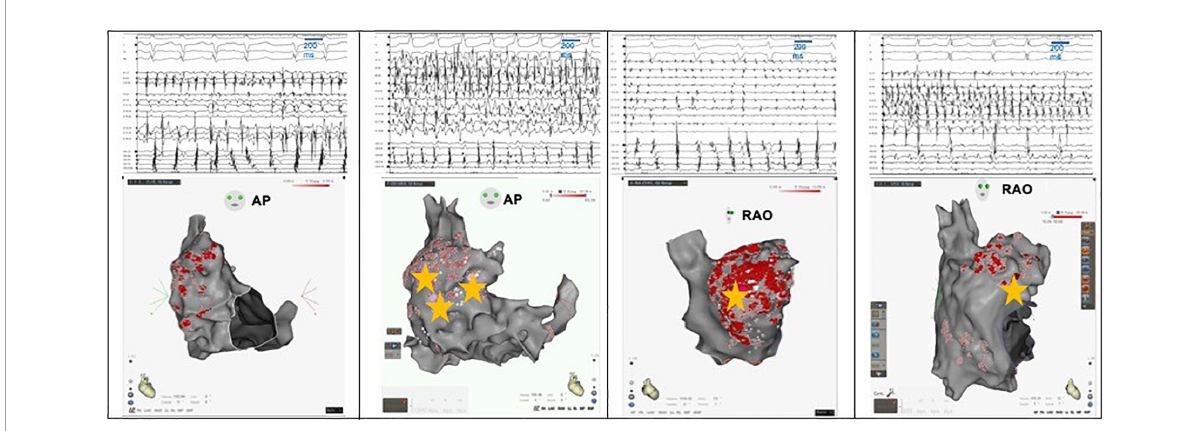
FIGURE2 Examples of RAAF in four different patients. A multi-spline catheter is positioned within the right atrial appendage and a decapolar catheter within the coronary sinus. Electrogram activations recorded within the right appendage are notably fast (cycle length around 100 ms significantly shorter than the one measured in coronary sinus) and fractionated . Three dimensional shells of the right atrium are presented either in the antero-posterior (AP) view or right oblique anterior (RAO) view. Ablation areas are presented with visitags “grids” (pink/red areas) and yellow stars represent termination